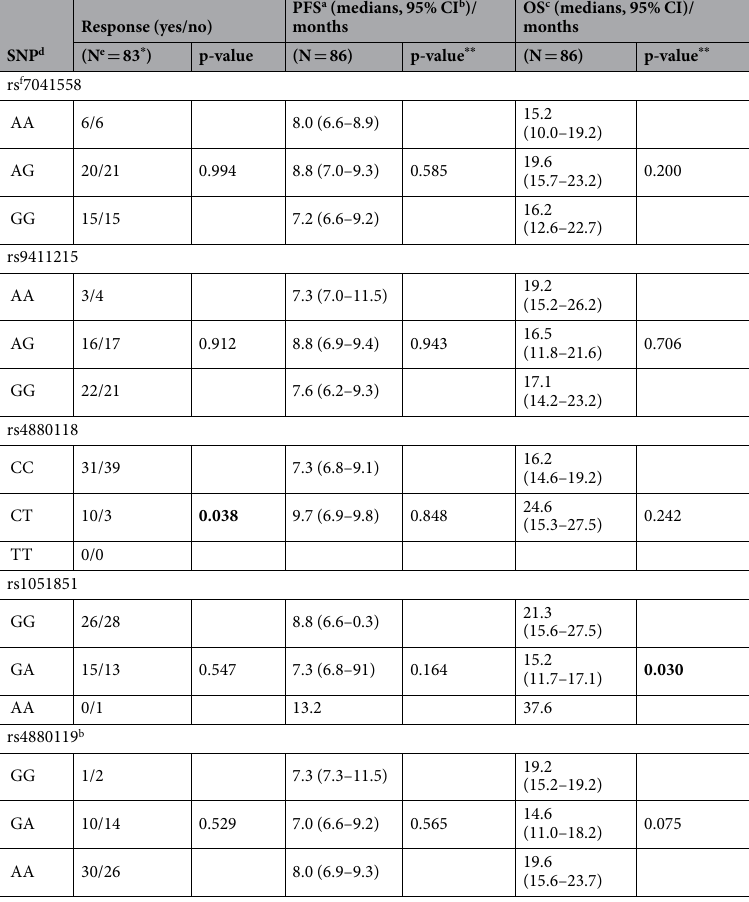
Table 4. Genotype distribution in relation to treatment response, progression free survival, and overall survival. PFS a , Progression free survival; CI b , Confidence interval; OS c , Overall survival; SNPd, Single nucleotide polymorphism; N e , Number; rs f : reference sequence. * Two patients had insufficient DNA for SNP analyses, three patients were not evaluable according to RECIST. ** p-values according to the Log-rank test